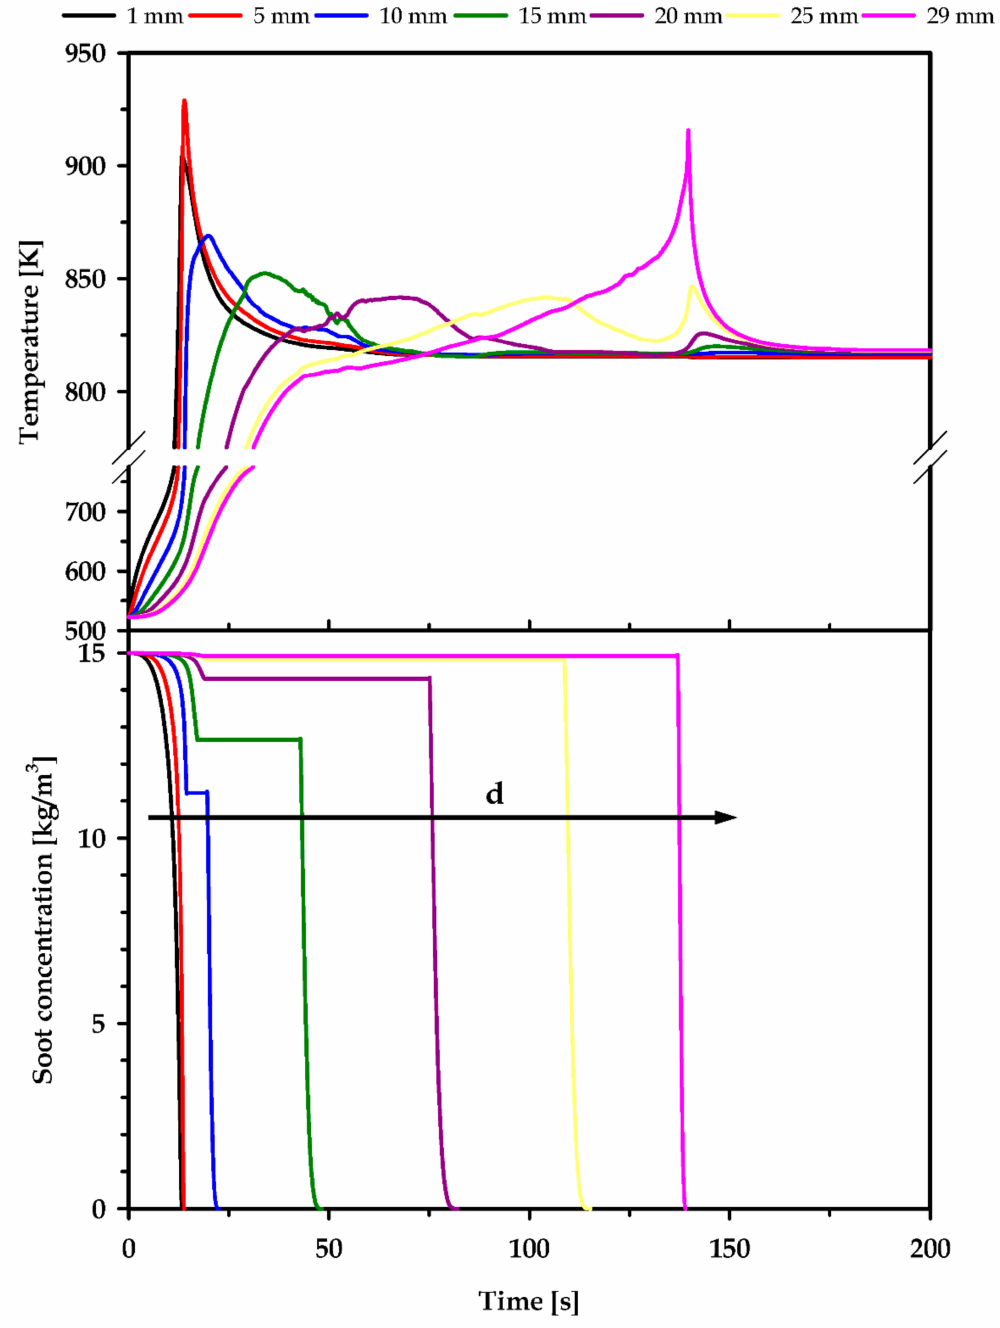
Figure 7. Time histories of temperature and soot concentration (monitor points of Figure 2): k = 200. The arrow indicates the direction of propagation of the reaction front: d = downstream propagation (from upstream—1 mm-to downstream—29